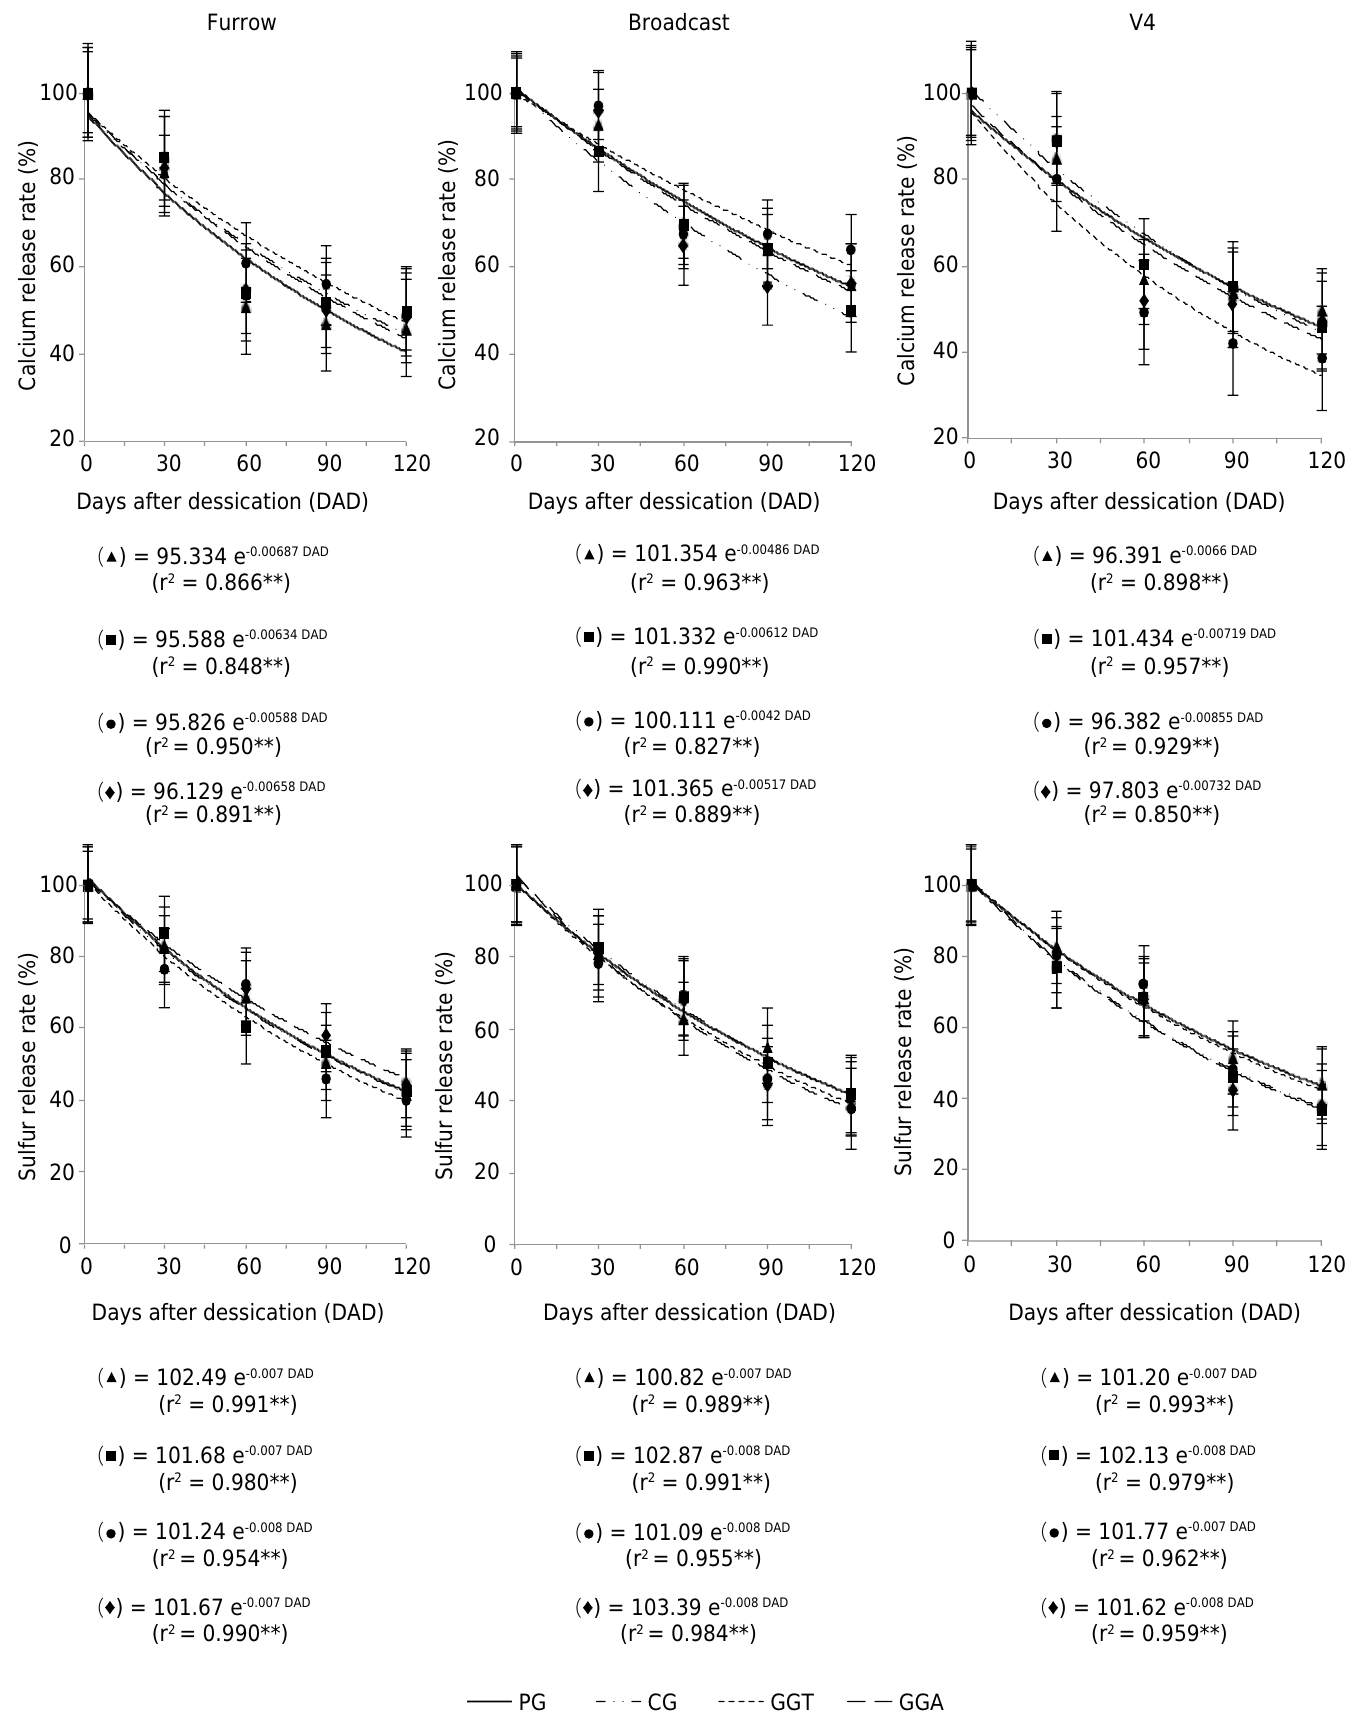
Figure 5. Calcium and sulfur release rate from forage straw after dessication, in three methods of sowing forage-autumn maize intercrops. PG, CG, GGT and GGA: Palisade grass, Congo grass, Guinea grass cv. Tanzânia and Guinea grass cv. Áries, respectively. **: significant at 1